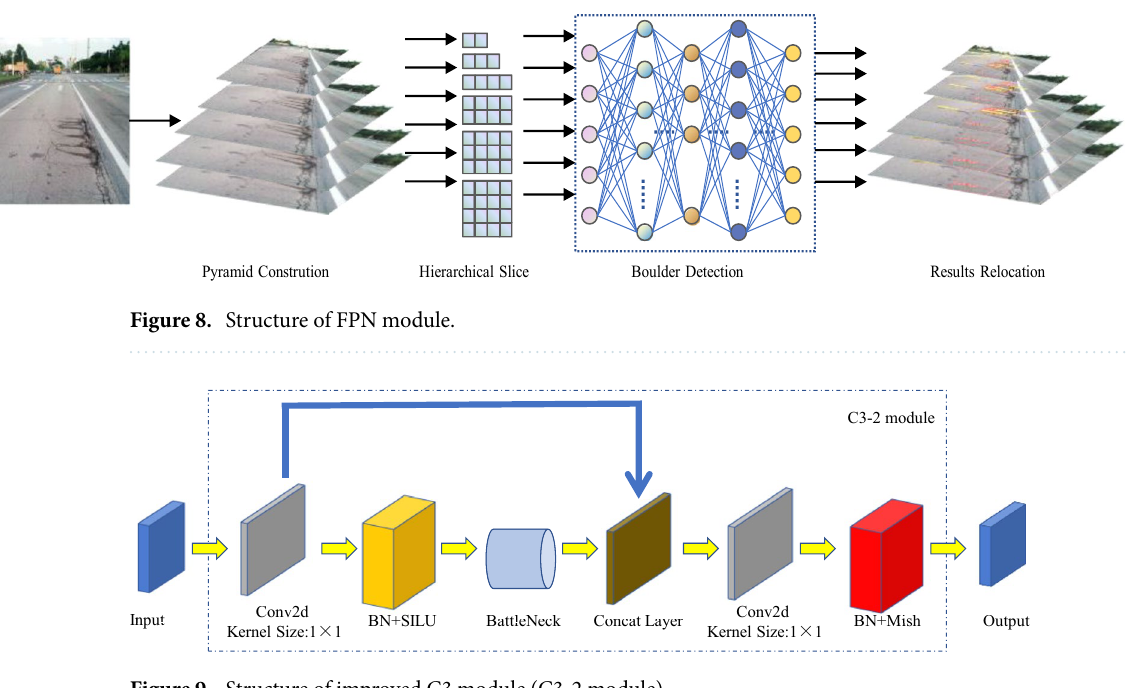
Figure 9. Structure of improved C3 module (C3-2